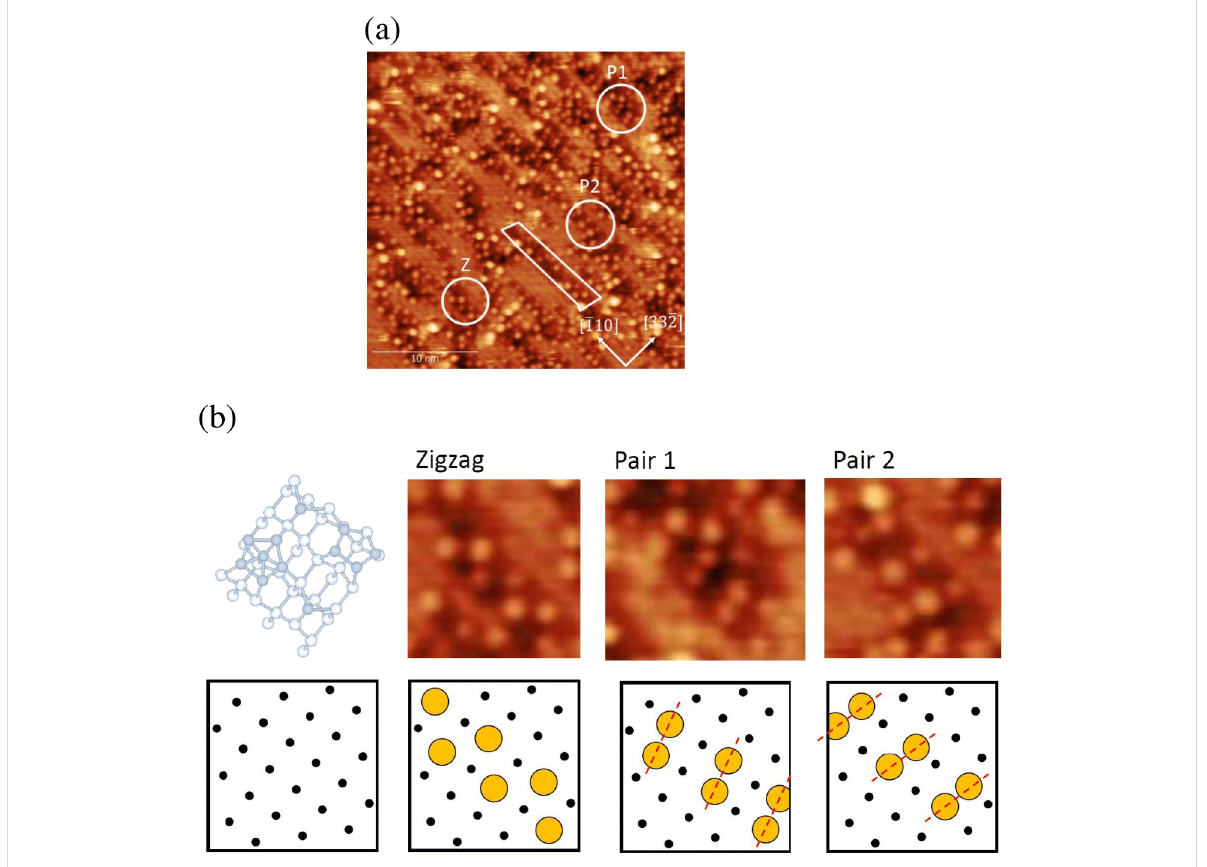
Figure 7: (a) High-resolution STM image of Si(113)-(3 × 2) upon oxidation at an oxygen pressure of 2.6 × 10 − 5 at 820 K, corresponding to the oxida- tion regime. Total oxygen exposure is 30 L. (b) Three areas showing typical patterns, denoted as Zigzag (Z), Pair 1 (P1), and Pair 2 (P2) in (a), are compared with the structure